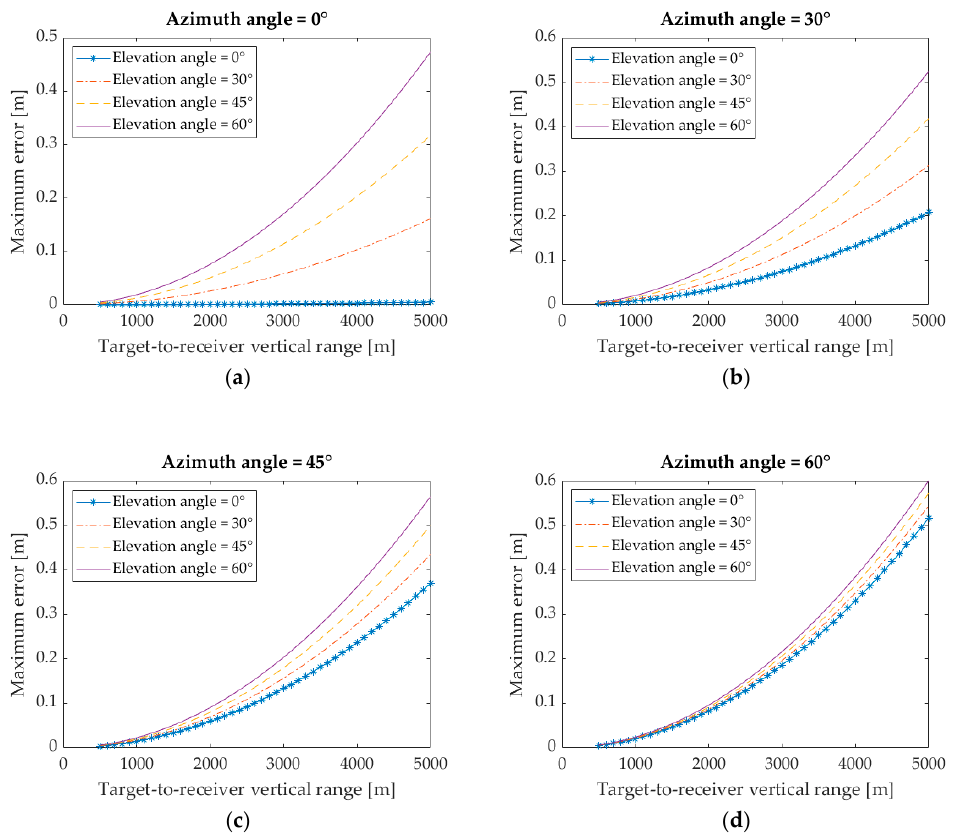
Figure 4. Maximum errors of the approximate bistatic ranges versus the target-to-receiver vertical ranges for different satellite elevation angles and satellite azimuth angles: ( a ) is azimuth angle = 0°, ( b ) is azimuth angle = 30°, ( c ) is azimuth angle = 45°, and ( d ) is azimuth angle = 60°.